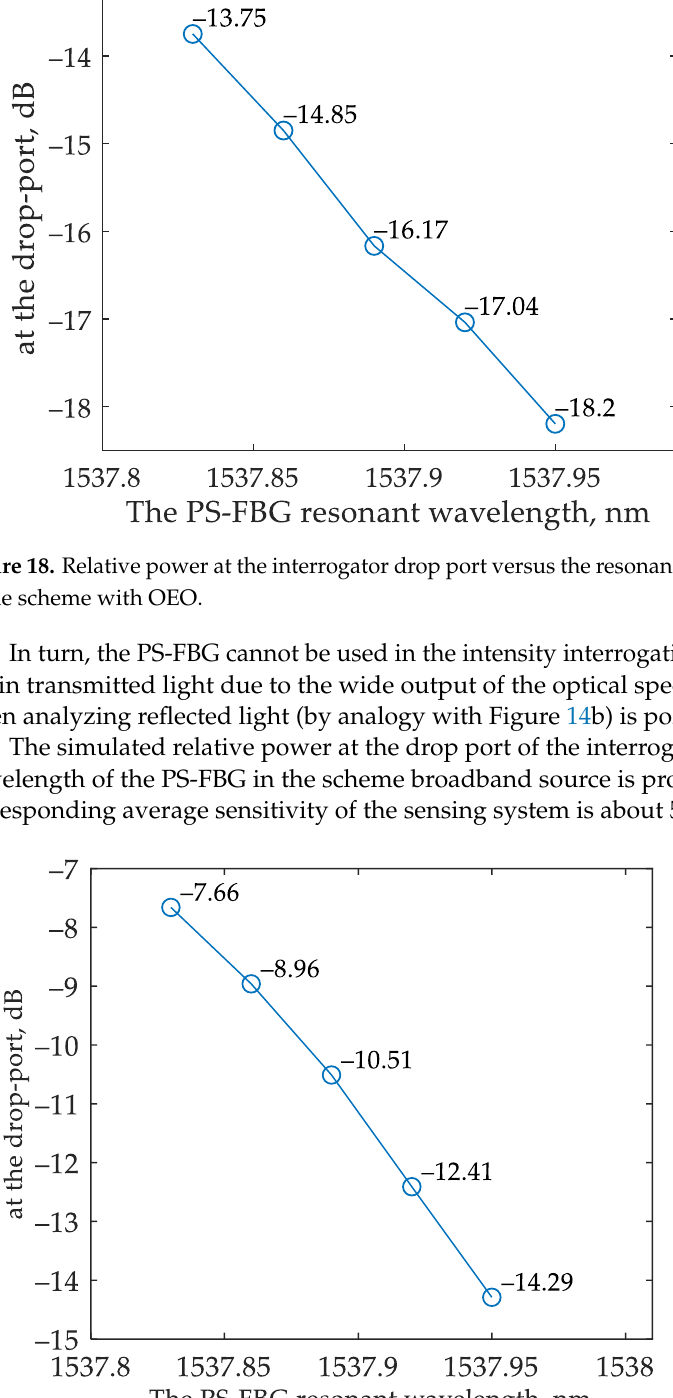
Figure 19. Relative power at the interrogator drop port versus the resonant wavelength of the PS- FBG in the scheme with broadband source.